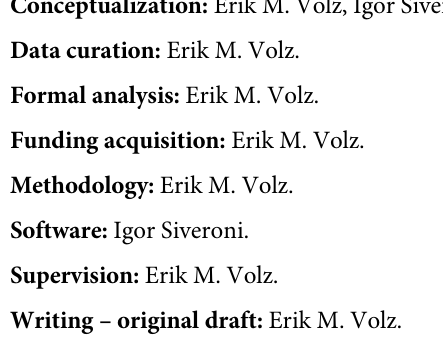
S1 Fig. Diagram representing dynamics of simulation model with four demes. This model has two levels of transmission rate (l and h) and two stages of infection with higher transmis- sion in the first stage. Solid lines represents death or stage progression. Dash lines represent transmissions. S2 Fig. Comparison of stochastic and deterministic trajectories. The stochastic epidemic simulation is shown in black and the deterministic ODE model is shown in red. S3 Fig. Effective population size of influenza H3N2 in New York 2014-15 estimated using GMRF skyride. The median posterior estimate is shown in the panel on the left, and the panel on the right shows both the median and 95% credible intervals. S4 Fig. Parameter estimates using the PL1 coalescent model and credible intervals for 25 simulations with variable transmission risk ratos. The red points show true parameter value. Top: Transmission rate. Middle: Acute stage transmission risk ratio. Bottom: High risk group transmission risk ratio. S5 Fig. Parameter estimates and credible intervals for 20 simulations. The red line shows the true value. A-C: Results generated using the PL1 model. D-F: Results generated using the QL model. The parameters are in the same order as Fig 5 in the main